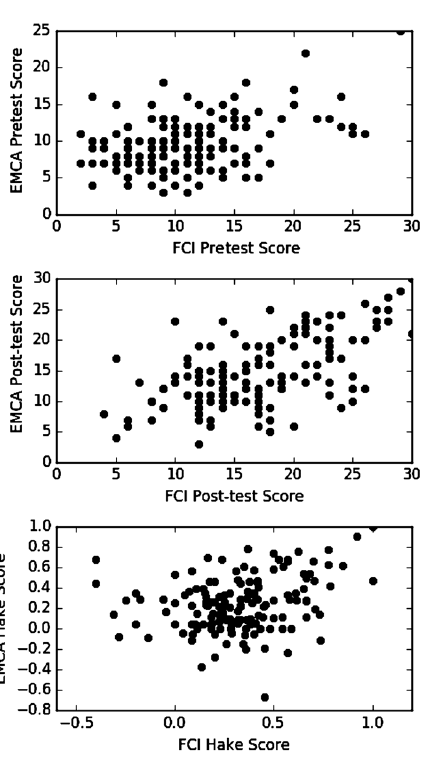
FIG. 8. Top: Pretest Scores of EMCAversus FCI. Middle: Post- test scores of EMCAversus FCI. Bottom: Normalized gain values of EMCA versus FCI. A Spearman rank correlation test analysis shows that there is a statistically significant correlation between the two scores for the 2015 and 2016